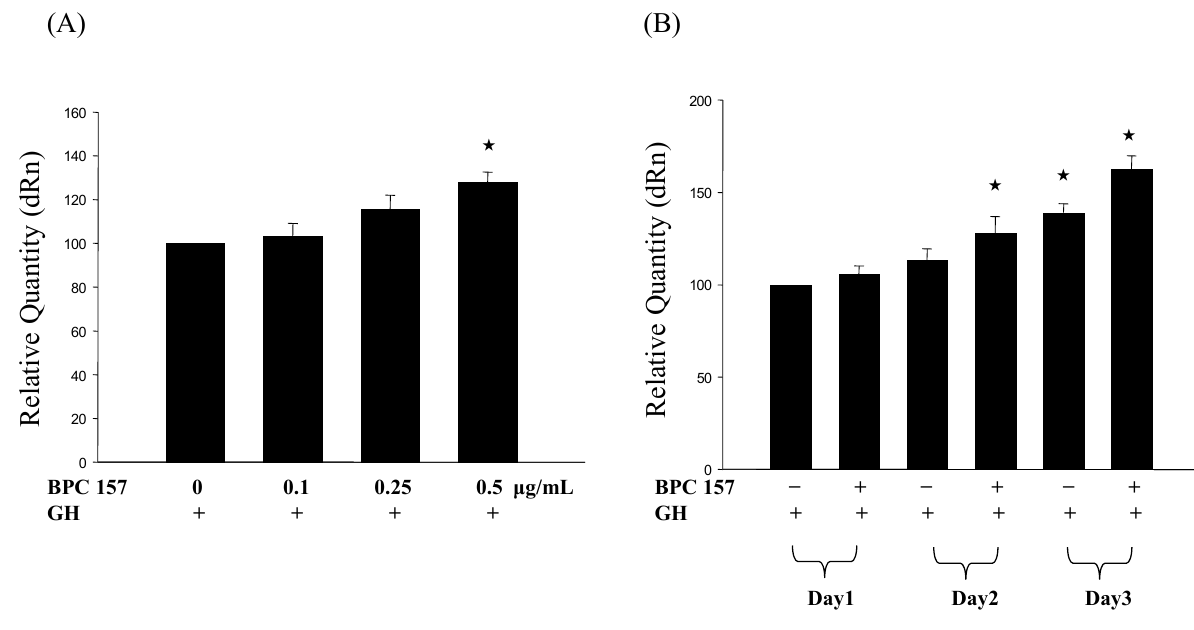
2.3. Growth Hormone Activated the Janus Kinase 2 Gene (Jak2) in BPC 157-Treated Tendon